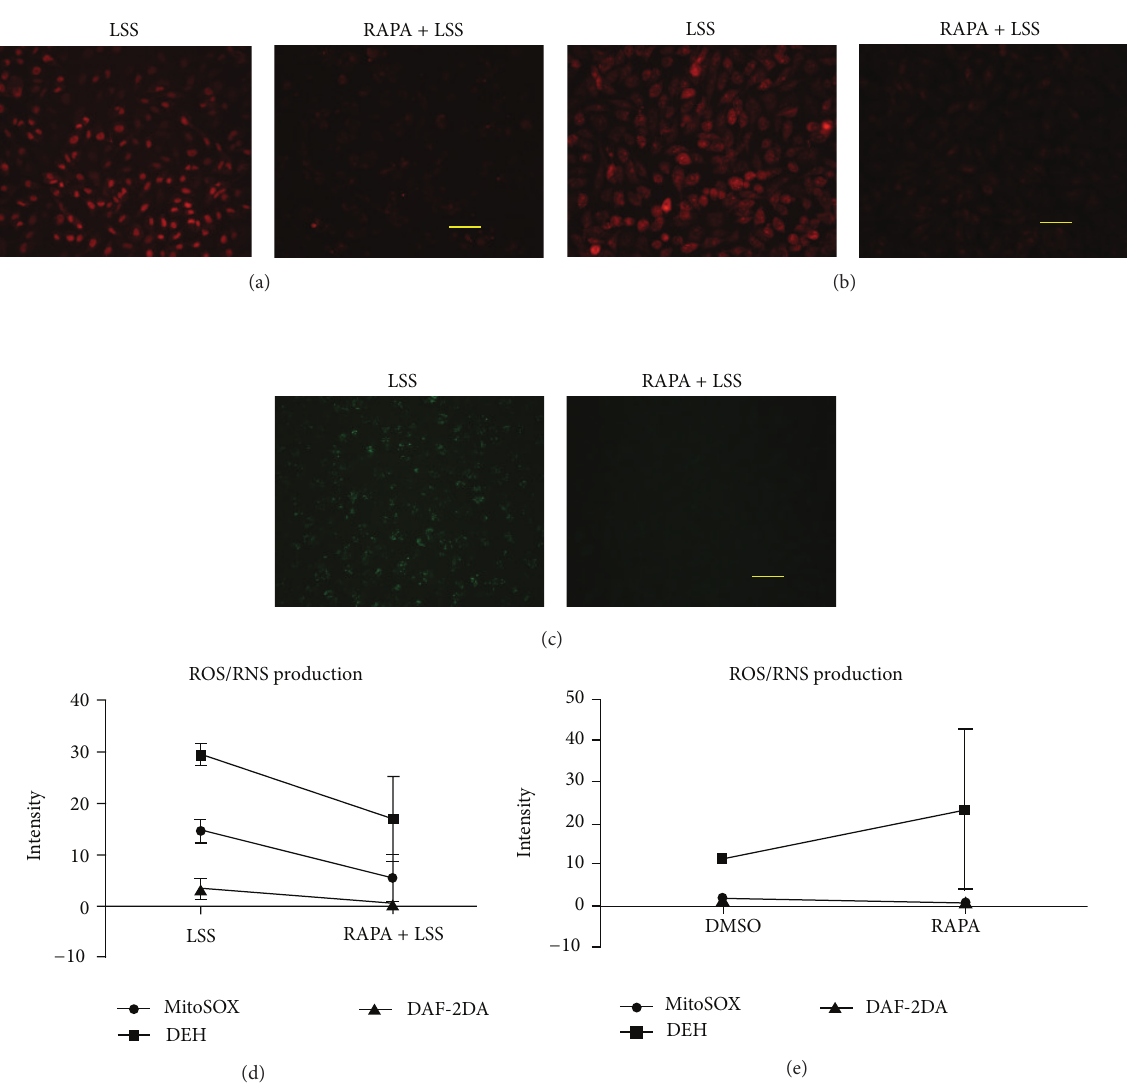
Figure 2: Rapamycin attenuated LSS induced ROS/RNS production in HUVECs. ROS/RNS accumulation caused by LSS at 2dyne/cm 2 for 120 min was attenuated by rapamycin (RAPA) at the concentration of 100ng/mL in HUVECs. (a) RAPA ameliorated the effect of LSS on promoting ROS production examined by mitoSOX. (b) Consistent result was observed with DHE staining. (c) RAPA attenuated LSS induced RNS accumulation assayed by DAF-2DA. Scale bars: 50 𝜇 m ((a)–(c)). (d) The line graph was the statistical results of fluorescence intensity and size at the fixed color threshold which showed the significant reduction of ROS or RNS production in RAPA + LSS group, ∗ 𝑃 < 0.05 ; 𝑛 = 10 . (e) RAPA did not significantly increase ROS or RNS production as compared with vehicle DMSO, 𝑃 = 0.1279 with ANOVA, 𝑛 = 10